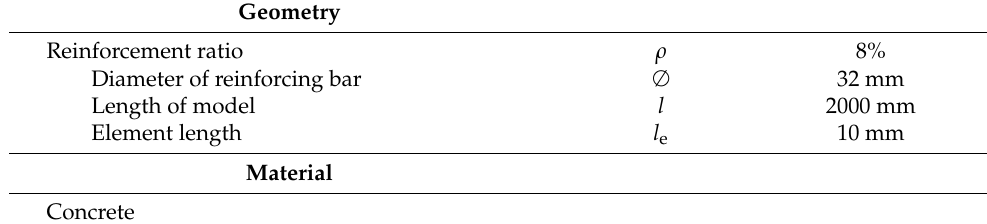
Figure 14. Details of the axial tensile specimen (dimensions shown in mm) [36].